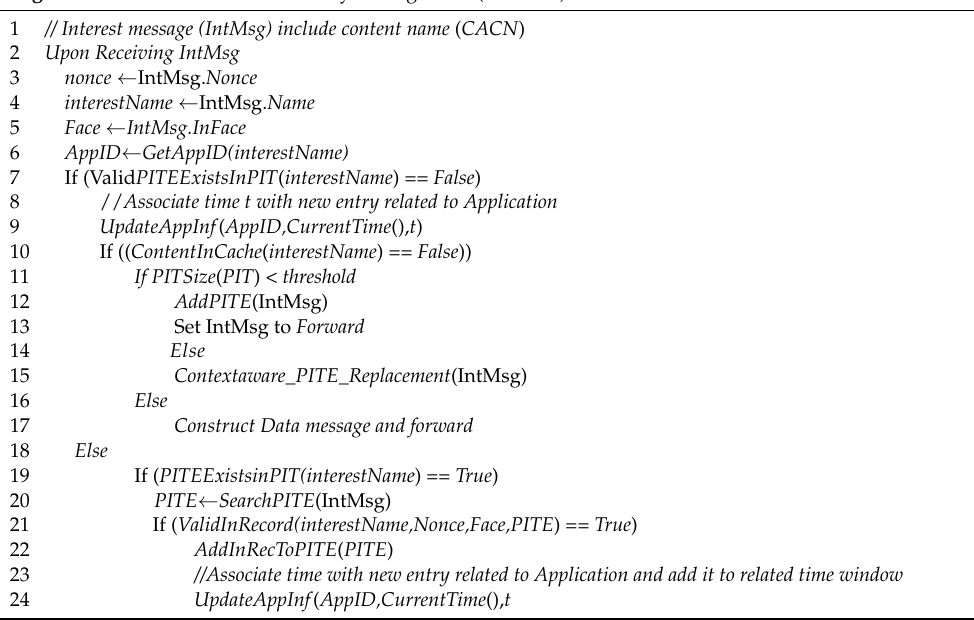
Algorithm 1: Context-aware PIT Entry Management (CPITEM)